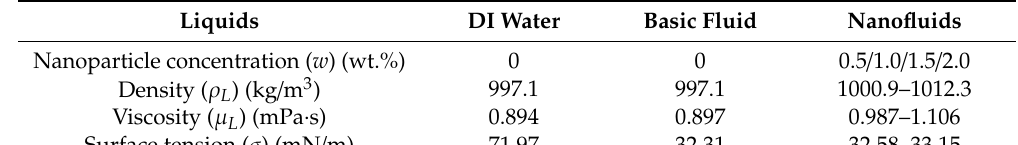
Figure 1. Dispersion stability of Al 2 O 3 -H 2 O nanofluids and its microcosmic mechanism: ( a ) Nanofluids standing for 4 h; ( b ) Scanning electron microscopy images of γ -Al 2 O 3 nanoparticles; ( c ) Stable structure of the electron double layer.